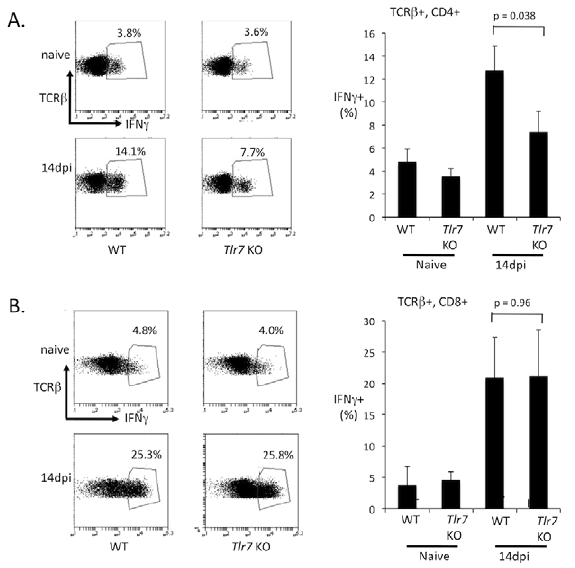
Figure 8. TLR7 is required for IFN c expression in CD4 T cells. Wild-type (WT) and TLR7 deficient ( Tlr7 KO) mice were infected with FV. At 14 dpi, splenocytes were harvested, restimulated for 3 h with PMA/ ionomoycin, and analyzed by flow cytometry for intracellular expression of IFN c in ( A ) CD4 T cells (TCR b + , CD4 + ) and ( B ) CD8 T cells (TCR b + , CD8 + ). A representative flow cytometry plot for the T cell gated cells for each group is shown. Each bar of the histogram represents the average of 5–6 mice.